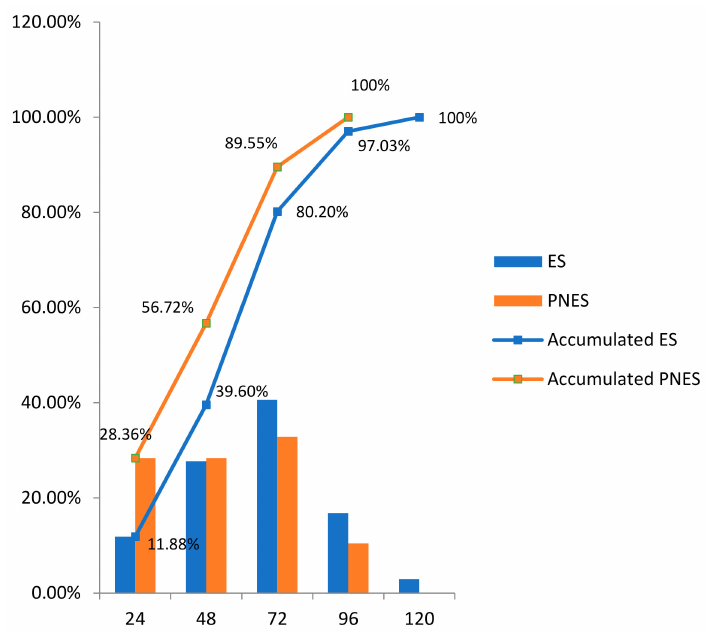
Figure 6. Distribution of daily accumulated events.